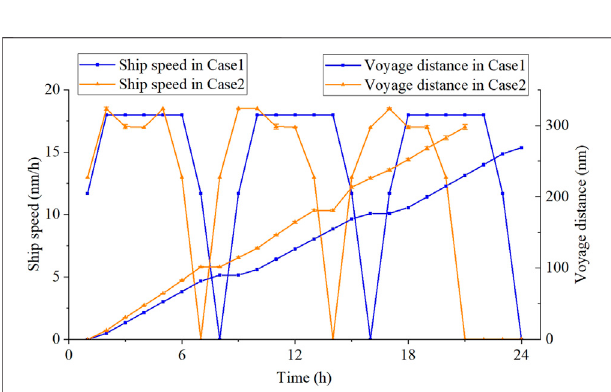
FIGURE 6 | Hourly voyage outputs of coordination of optimal power management and voyage